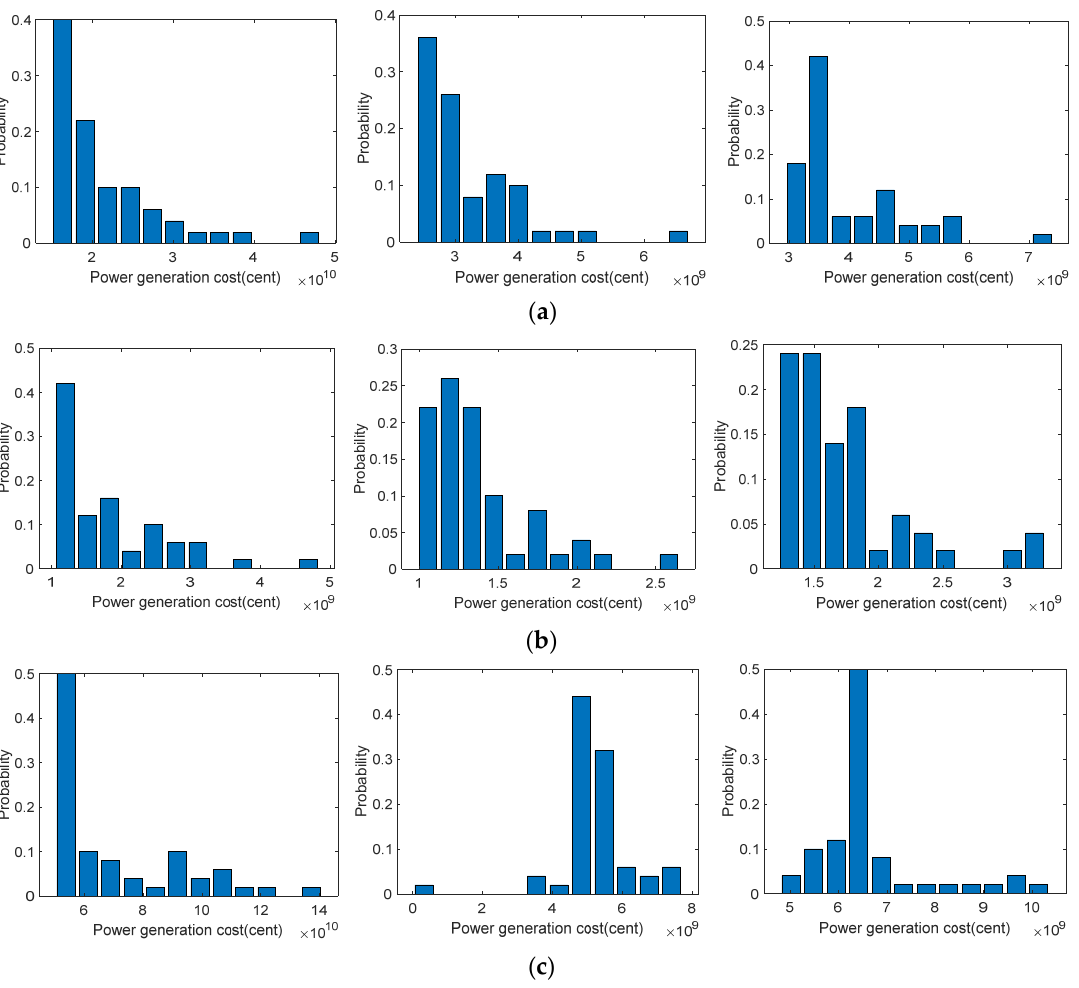
Figure 13. Probabilistic density maps of the total cost of three energy hubs under different wind speed series in different seasons: ( a ) spring and autumn (energy hub1, energy hub2, energy hub3); ( b ) summer (energy hub1, energy hub2, energy hub3); ( c ) winter (energy hub1, energy hub2, energy hub3).